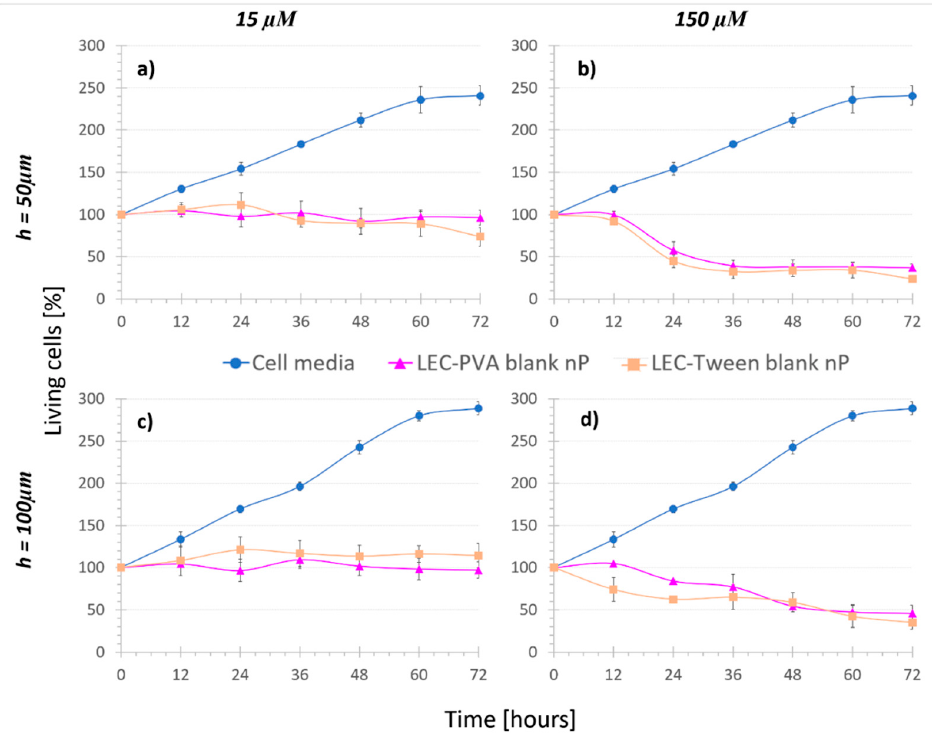
Figure 3. Cell viability under the recirculation of cell media and “Nanoparticle control” assays, where ( a , b ) are for 50- µ m high platforms and ( c , d ) for 100- µ m high platforms (n = 4). The recirculation of blank lipid nanoparticles reduced the cell population when increasing the concentration.